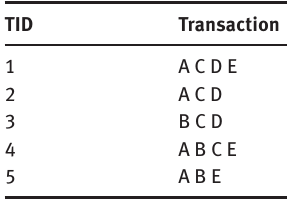
Table 4: Incremental Database db.